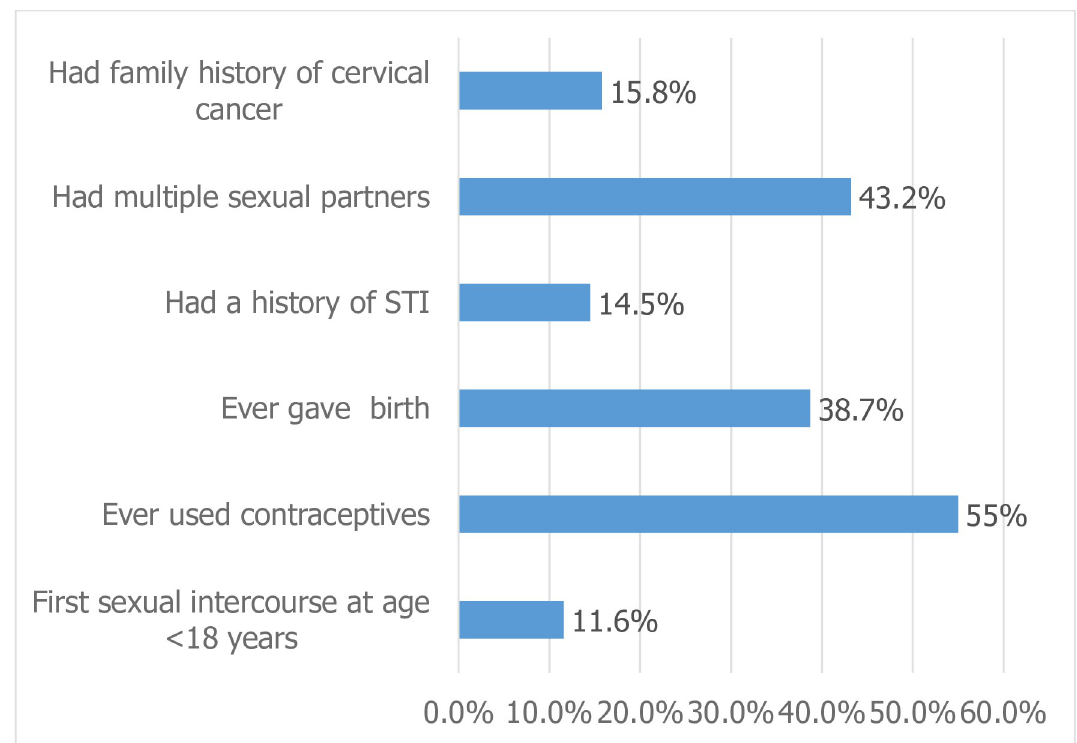
Fig 2. Reproductive health-related characteristics of females (15–49 years) in Durame town, SNNPR, Ethiopia, 2020 (n = 442) (Multiple responses were possible).